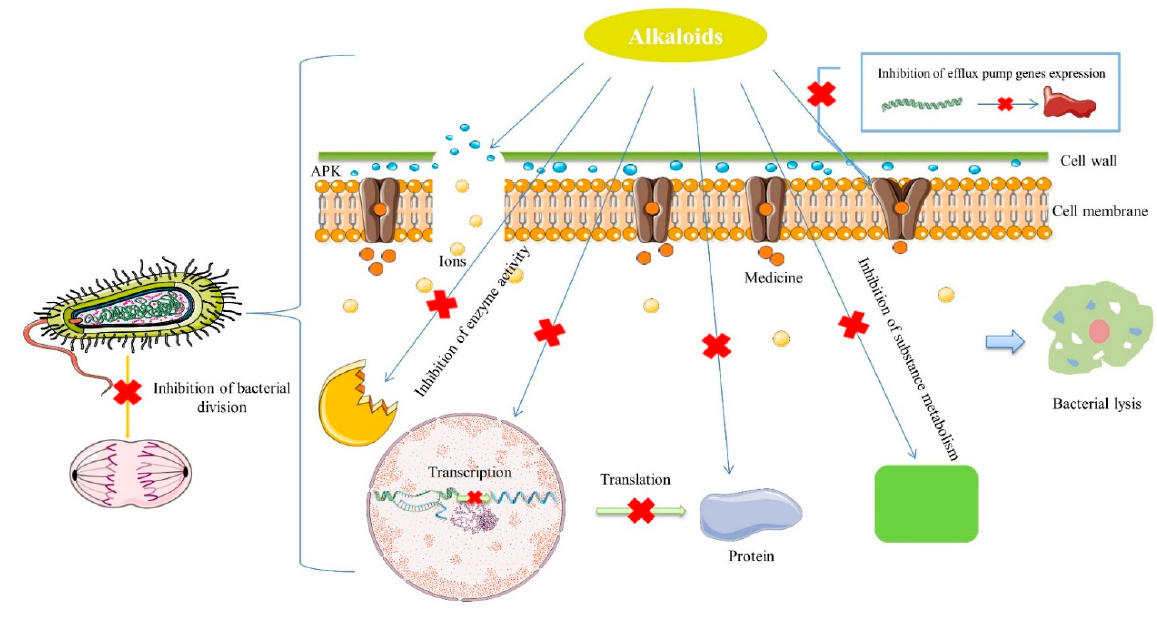
Figure 1. Antibacterial mechanism of natural